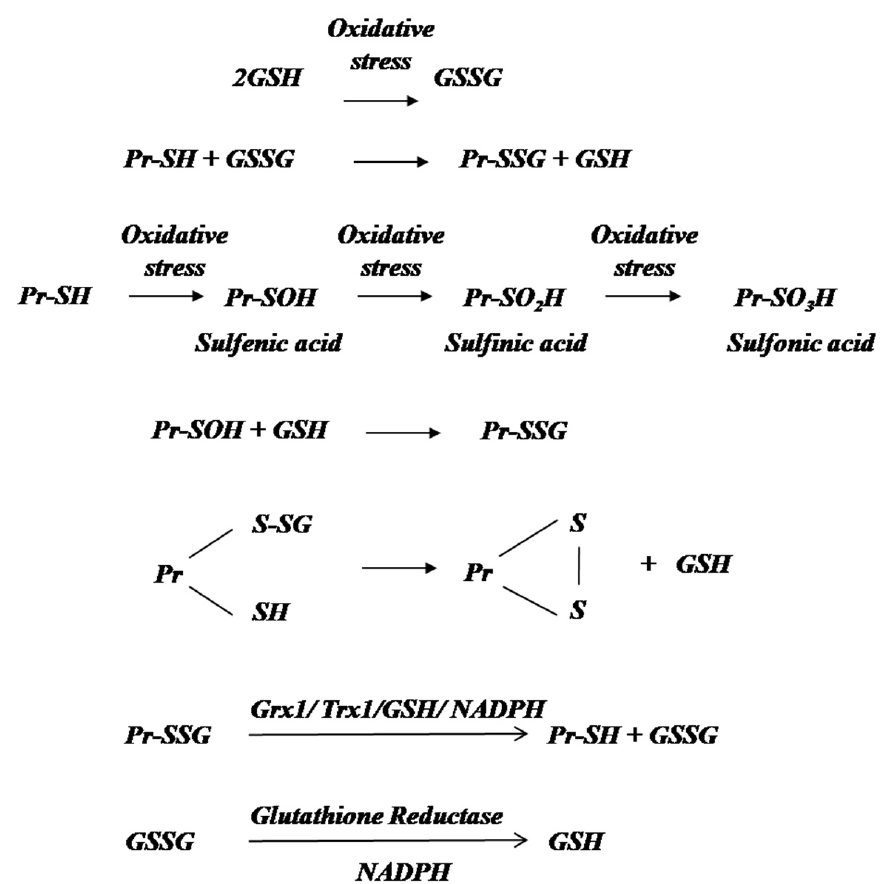
Figure 1. Protein thiol modification during oxidative stress. During oxidative stress, GSH is oxidized to GSSG, which promotes the oxidative modification of protein thiols (Pr-SH) to protein glutathione mixed disulfides (Pr-SSG). Protein thiols can be directly oxidized to organosulfur oxoacids sulfenic (Pr-SOH), sulfinic (Pr-SO2H) and sulfonic acid (Pr-So3H). Sulfenic acid can be glutathionylated to prevent its further oxidation to irreversible sulfonic acids. Pr-SSG can undergo further modifications to form protein mixed disulfides. Pr-SSGs are reduced back to protein thiols by Grx1 or Trx1 utilizing the reducing equivalent of NADPH. GSSG formed in this reaction is effectively reduced to GSH by glutathione reductase using the reducing equivalent of